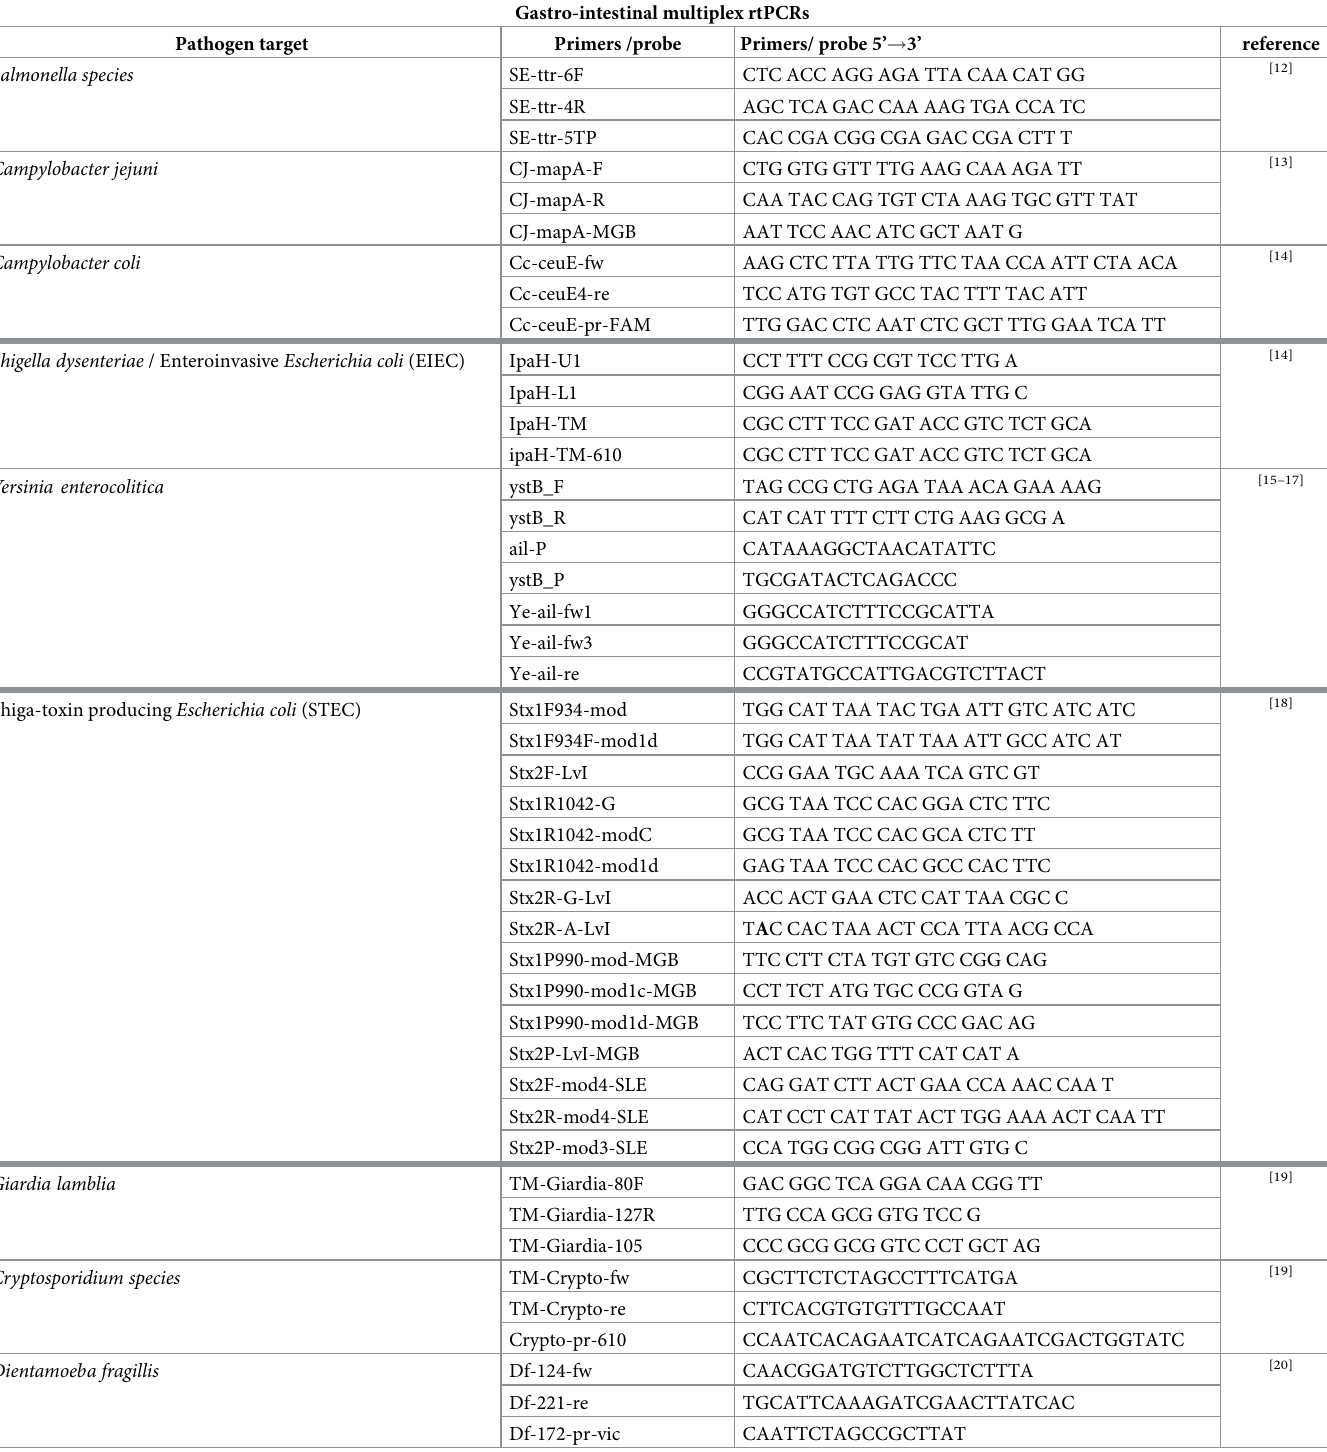
Table 1. Primers and probes